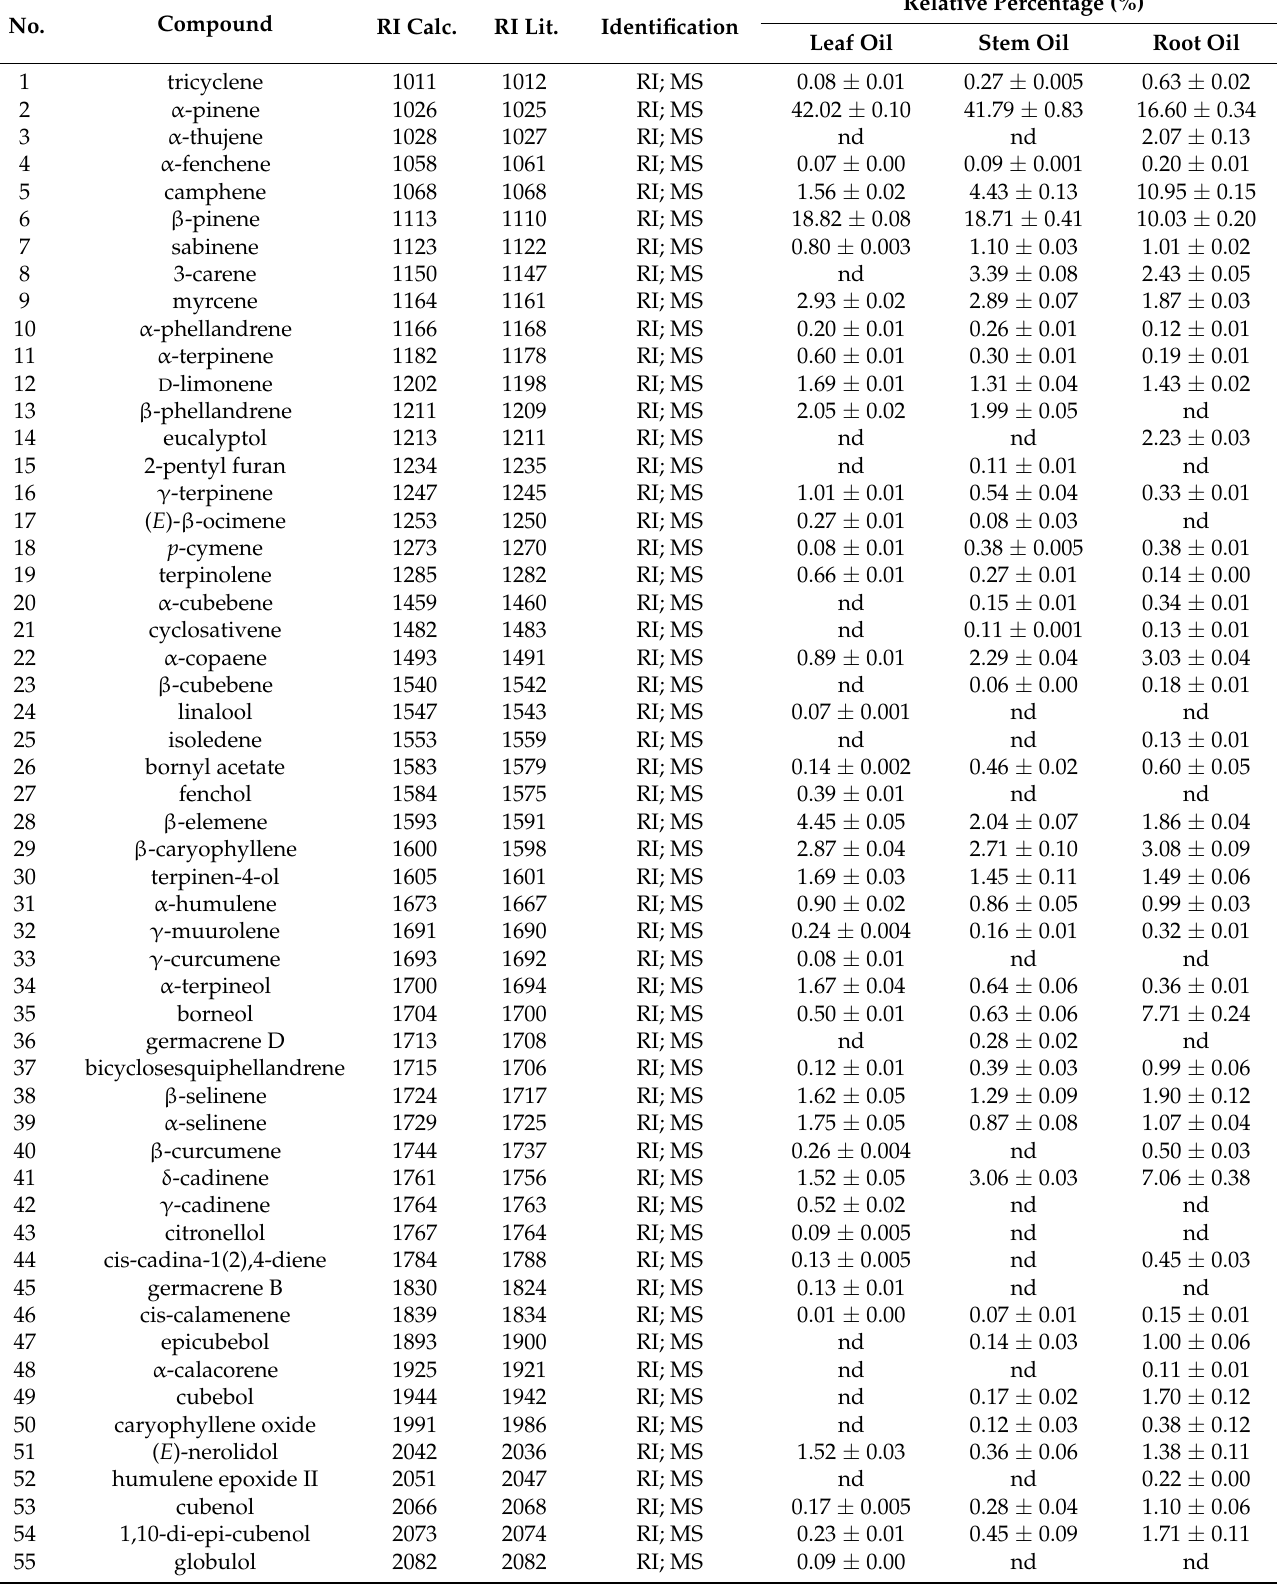
Table 1. Chemical compositions of the essential oils from the leaves, stems, and roots of K. coccinea